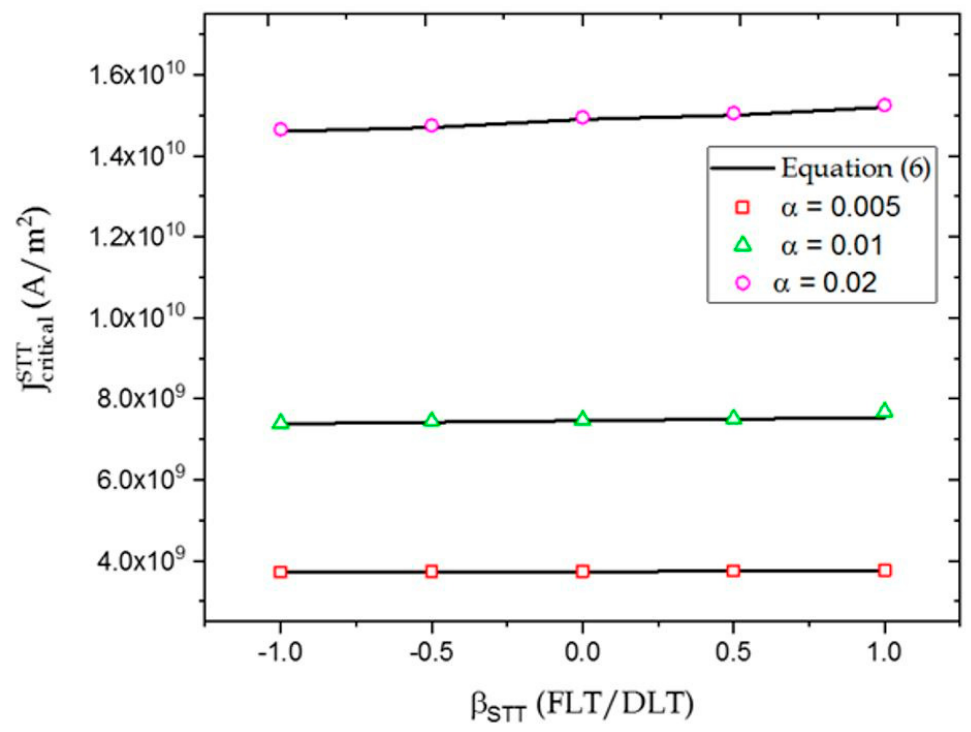
Figure 3. Dependence of J STT on β STT for α = 0.005, 0.01, 0.02. The solid lines and symbols represent the results obtained from Equation (6) and micromagnetic simulations respectively.